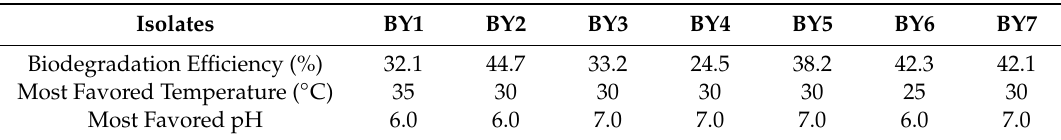
Table 2. The summarization of biodegradation e ffi ciency of the isolates and its favored temperature and pH